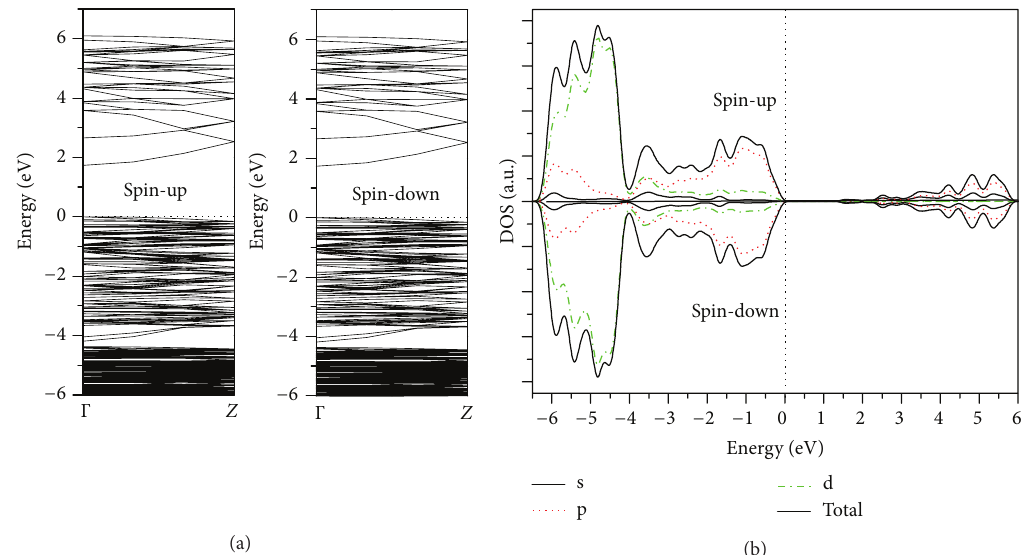
Figure 3: Calculated BS, total DOS, and PDOS of the pure ZnO nanowire. The Fermi level is set to zero on the energy scale, which will be adopted below unless otherwise stated.